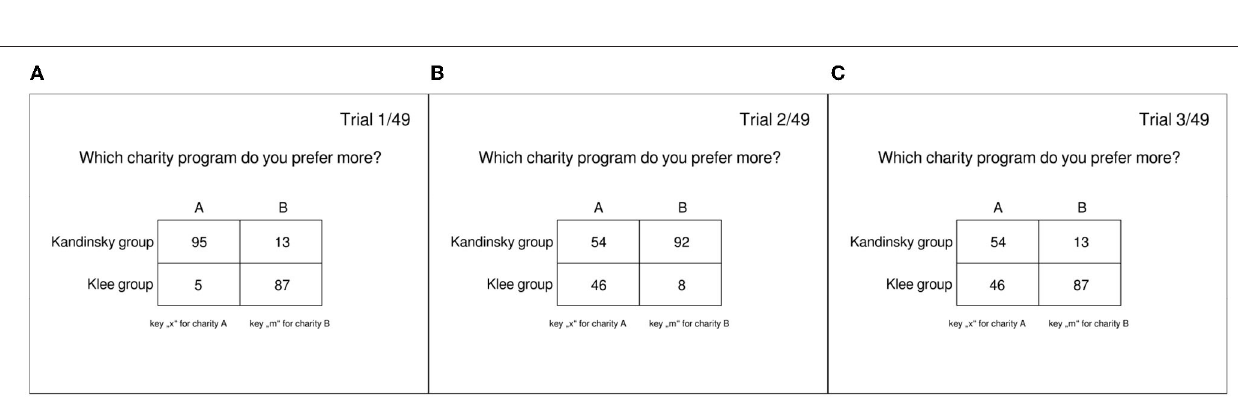
FIGURE 1 | Exemplary representation of the experimental procedure. Between trials, a blank screen was displayed for 200, 400, or 600 ms.